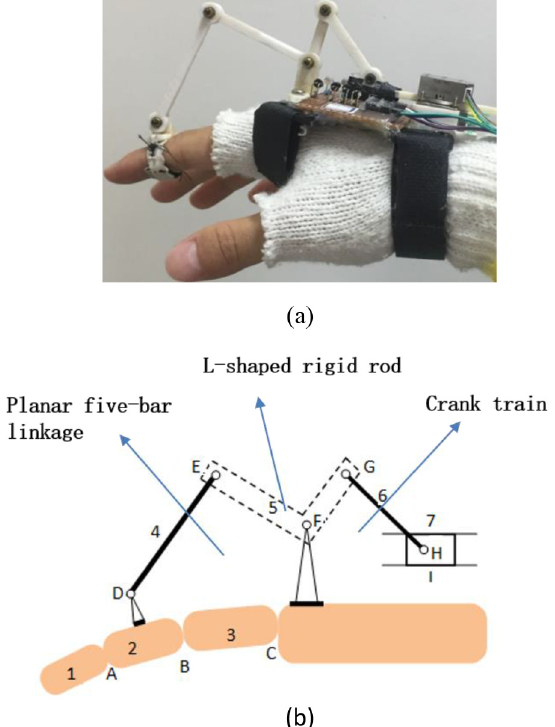
Fig. 12. The fi nger wearable device. (a) Outside view;